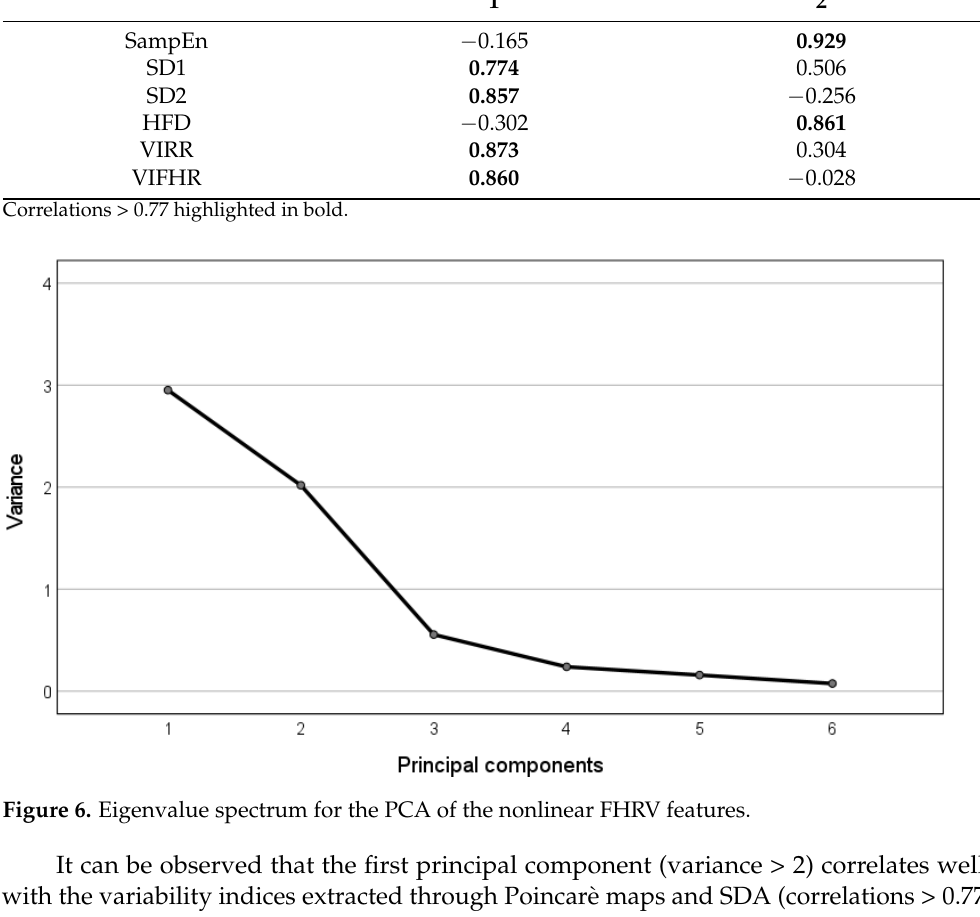
Table 4. Final subset of features obtained through the bwPCA.